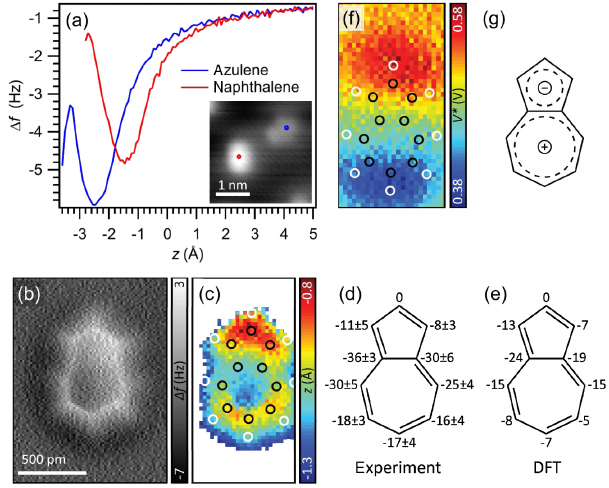
FIG. 7. (a) Δ f ð z Þ spectra over azulene and naphthalene , which is indicative molecules illustrating the difference in z min of the difference in adsorption height. The inset is an STM image, where the blue and red dots indicate the positions at which the Δ f ð z Þ spectra were taken. The STM image was acquired with I ¼ 10 pA at U ¼ 100 mV. (b) Constant-height nc-AFM image t t of a single azulene molecule at − 180 pm w.r.t. an STM set-point of 10 pA at 100 mV. (c) z map of azulene, overlaid with carbon min (black) and hydrogen (white) atom positions. (d) Experimentally obtained z height of all C atoms with respect to the C atom at min the apex of the 5-membered ring, in pm. (e) z heights of all C min atoms with respect to the nose-C atom calculated by DFT, in pm. (f) KPFM map of a single azulene molecule, overlaid with carbon (black) and hydrogen (white) atom positions. (g) Model of the azulene molecule indicating the direction of the dipole